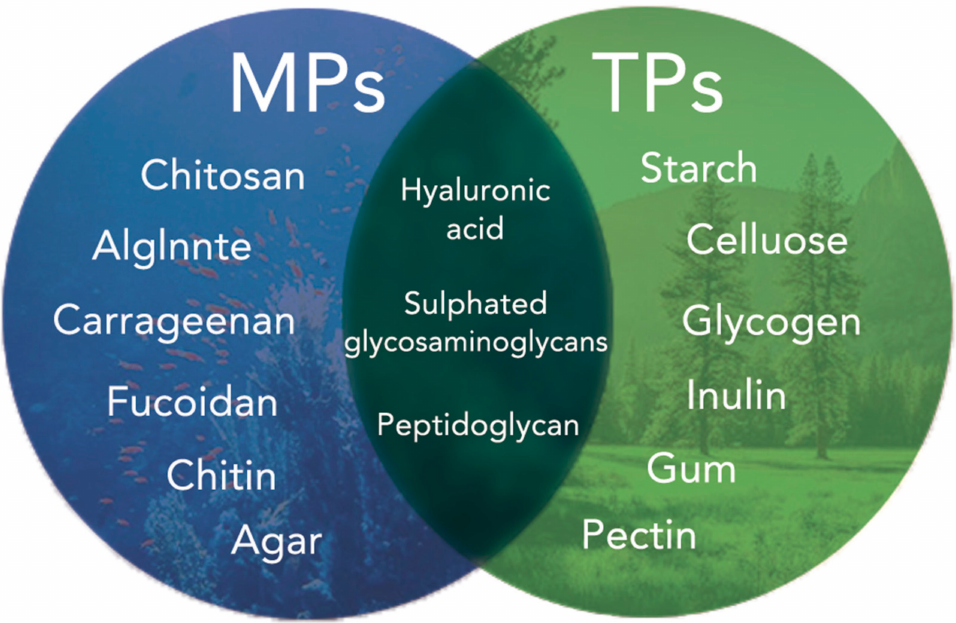
Figure 2. Classification of polysaccharides according to the source of